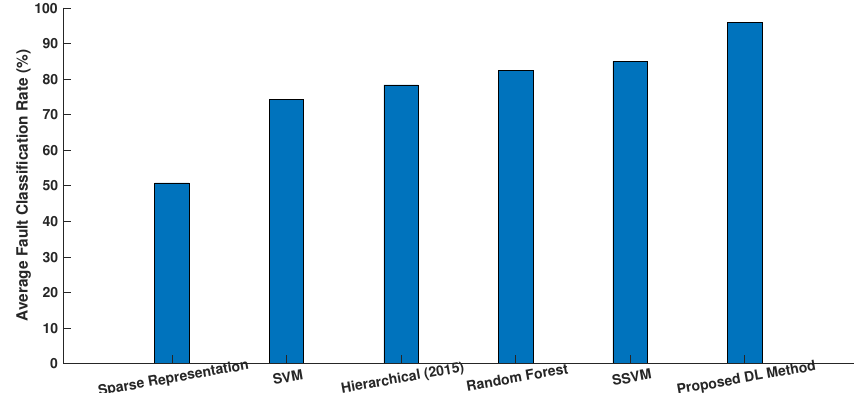
Figure 10. Comparison of averaged fault classification rates (non-incipient faults only).